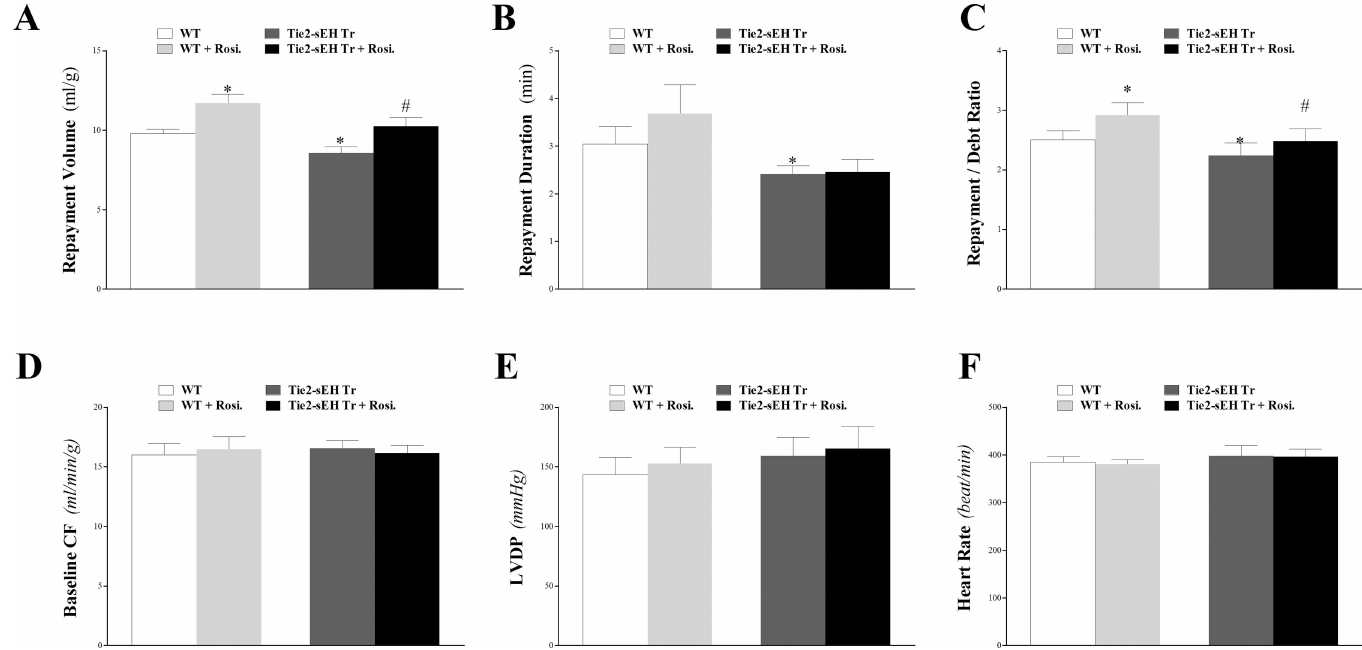
Fig 9. Effect of the PPAR γ -agonist (rosiglitazone, 10 μ M) on coronary reactive hyperemia (CRH) in Tie2-sEH Tr and WT mice. The PPAR γ -agonist, rosiglitazone, enhanced CRH in both Tie2-sEH Tr and WT mice. Repayment volume (A), and repayment/debt ratio (C) were increasedin both strains. Repayment duration(B) was increasedin WT mice, but not in Tie2-sEH Tr mice. Repaymentvolume was decreased more in Tie2-sEH Tr comparedto WT mice. BaselineCF (D), LVPD (E), and HR (F) were not different betweenthe two groups. * P < 0.05 versus WT. # P < 0.05 versus rosiglitazone–treatedWT. n = 8 per